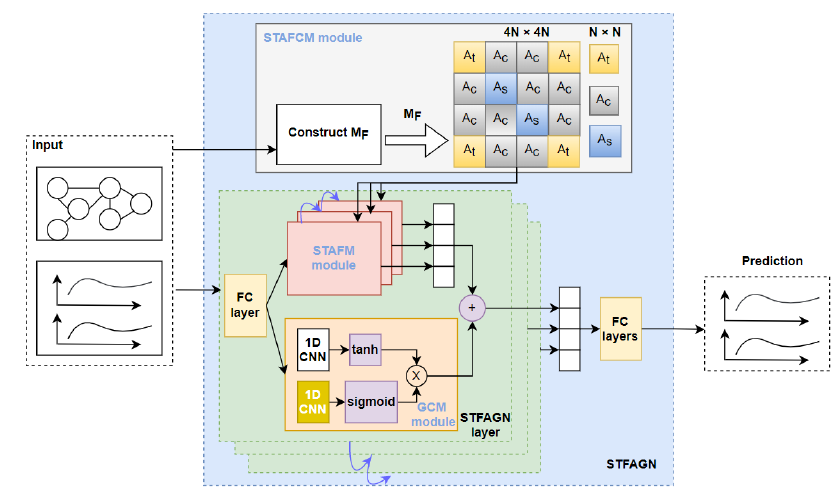
Figure 1. The particular framework of